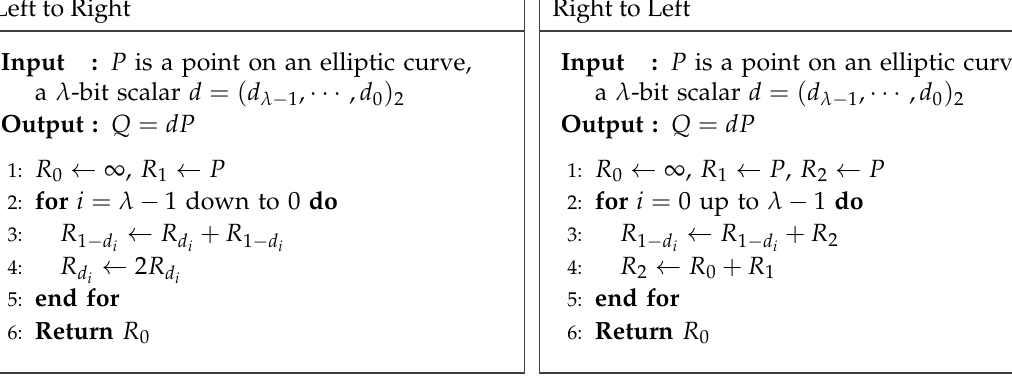
Figure 2. Examples of simple-power analysis (SPA)-resistant regular algorithms for binary scalar